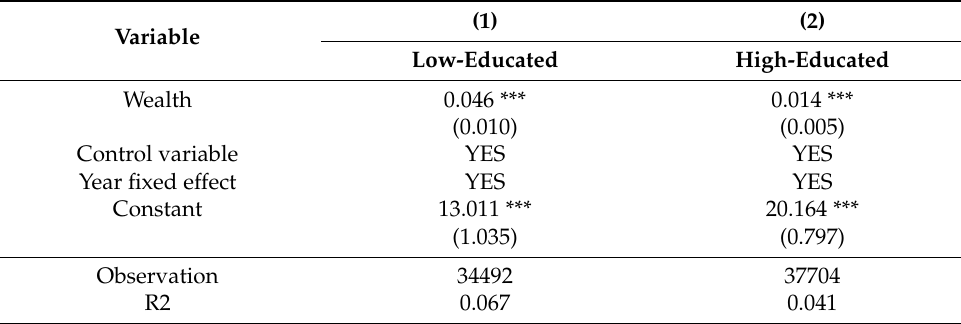
Table 5. Heterogenous effect with respect to the different education